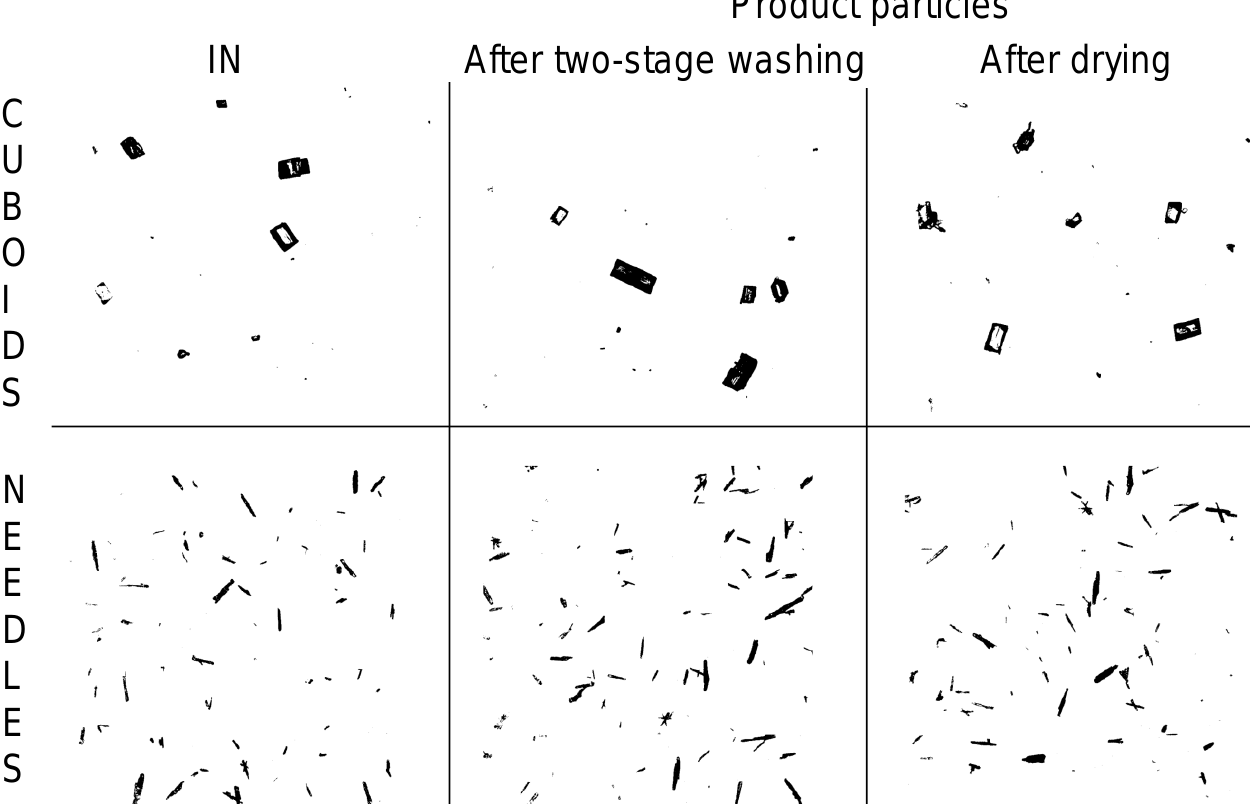
Figure 9. Exemplary QIPCIC binary images of the inlet suspension (left), product particles after two-stage washing (middle, compare ALD OUT of Figure 5), and product particles after washing and drying (right, compare ALD OUT of Figure 8): upper half — for cuboid-shaped particles; lower half — for needle-shaped particles.